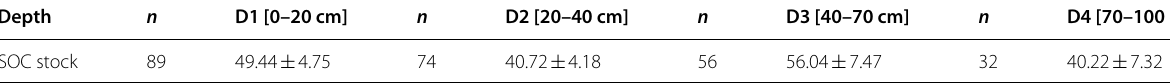
SE) values for the successive core-depth intervals of the soils within the ±